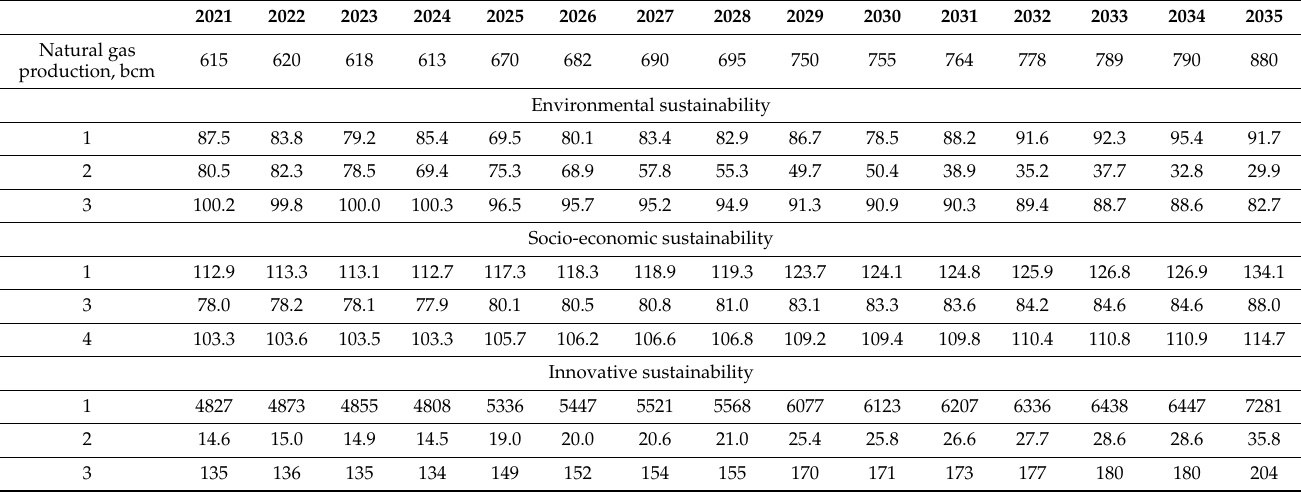
Table 4. Estimated values of the indicators reflecting the development of the Yamalo-Nenets Autonomous Okrug within the framework of the proposed sustainability indicators.